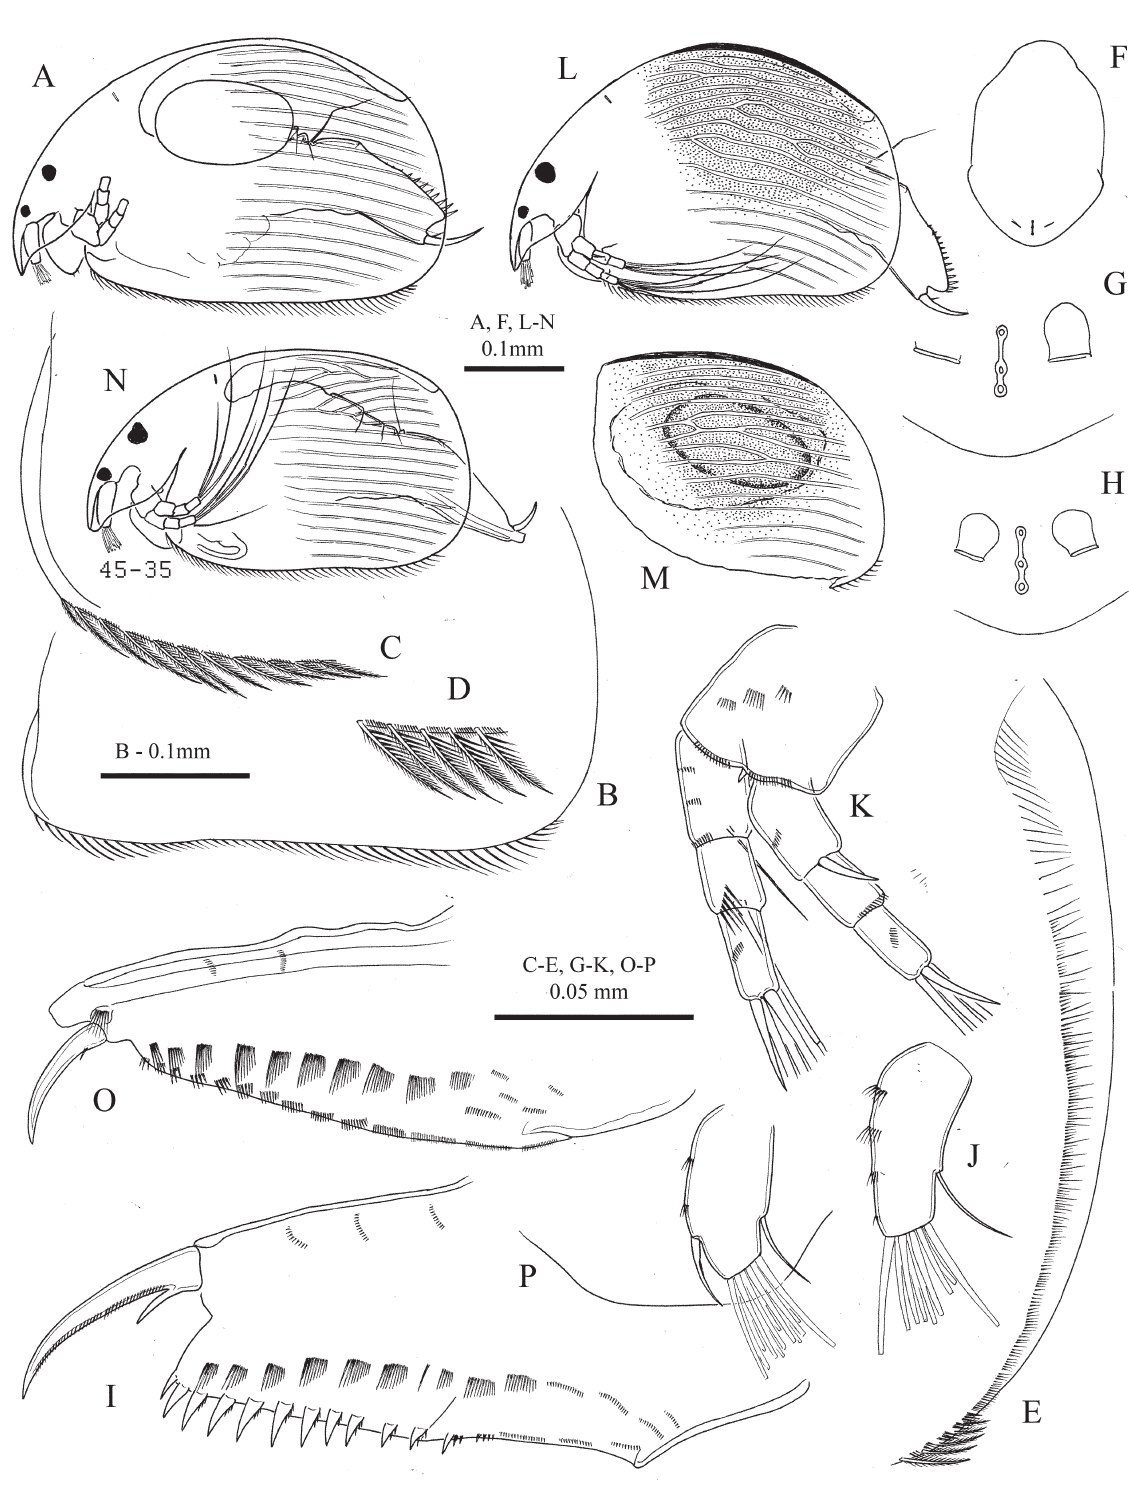
Fig. 1. Flavalona costata (Sars, 1862) comb. nov., Randsfjorden Lake, Norway. A–K . Parthenogenetic ♀. A . Lateral view. B . Ventral margin of valves. C . Anterior setae of valves. D . Posterior setae of valves. E . Posteroventral corner and posterior margin of valves. F . Head shield. G–H . Head pores. I . Postabdomen. J . Antennule. K . Antenna. L . Ephippial ♀. M . Ephippium. N–P . ♂. N . Lateral view. O . Postabdomen. P . Antennule and outline of